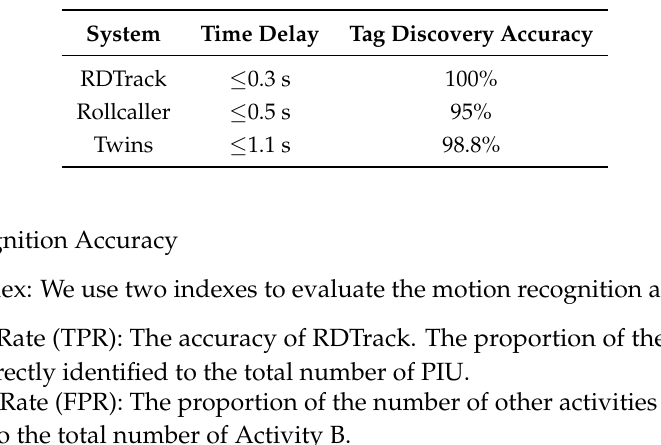
Table 2. The accuracy of the affected time of the tag.